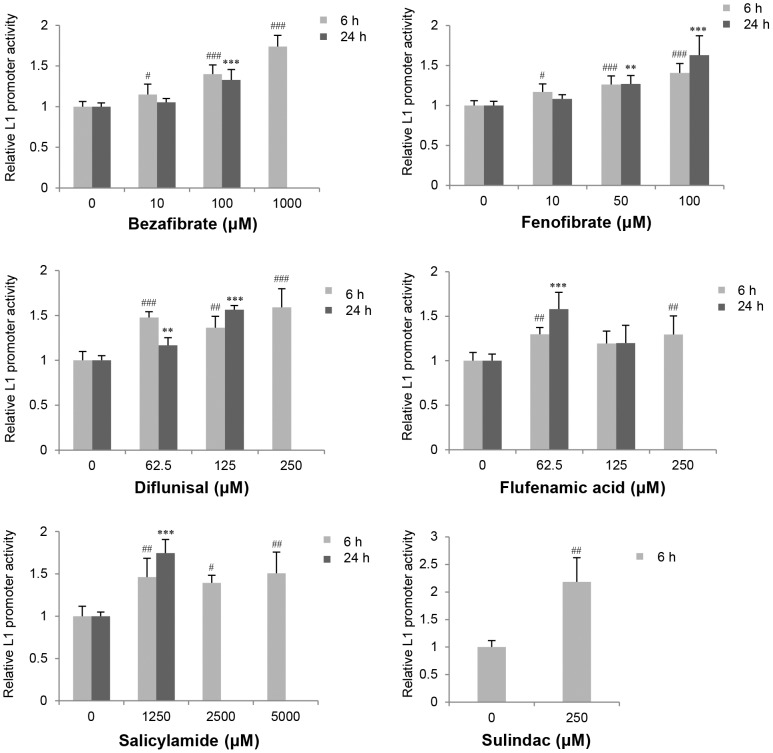
Effects of commercially available drugs on L1 promoter activity in HepG2 cells.L1 promoter activity 6 and 24 hours after treatment was evaluated by the luciferase reporter gene assay. Data are represented as the average ratio (± SD) of the L1 promoter activity in the presence of the test compound relative to that in the presence of the vehicle control from two independent experiments (in quadruplicate; n = 8) for bezafibrate and fenofibrate and from two independent experiments (in duplicate; n = 4) for diflunisal, flufenamic acid, salicylamide, and sulindac. The experimental data using sulindac are shown only after 6 hours because overt cytotoxicity occurred after a 24-hour exposure (data not shown). Statistically significant differences as compared with the vehicle control for 6-hour and 24-hour treatments are indicated by *or #, respectively (#, p<0.05; **or ##, p<0.01; ***or ###, p<0.001).